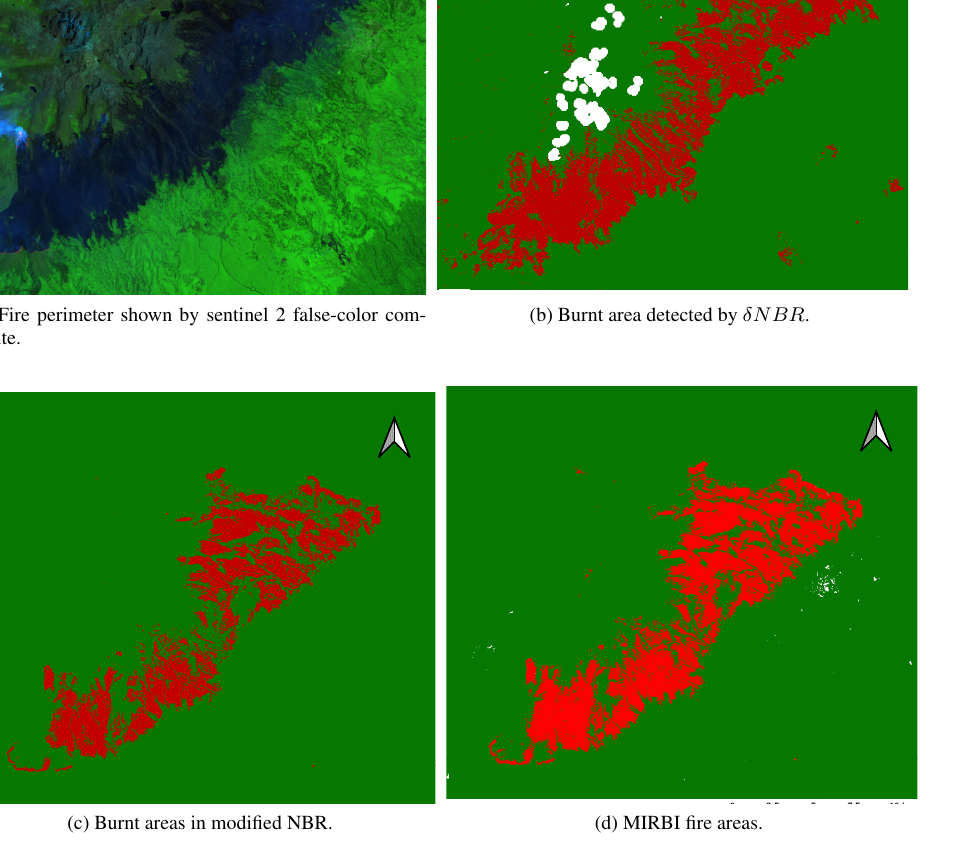
Figure 4. Burnt area (red colour) detected using different spectral indices.